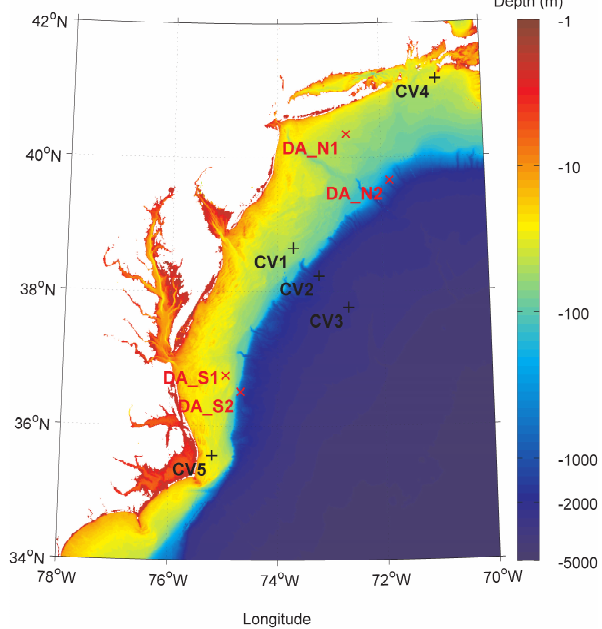
Figure 1. Locations of the nine study sites in the Mid-Atlantic Bight. The red crosses represent the four data assimilation (DA) sites, and the black pluses the five cross-validation (CV)